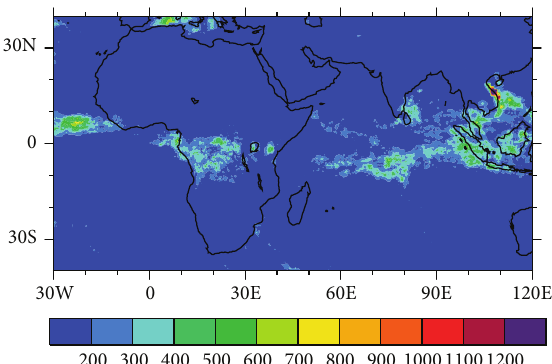
Figure 5: Rainfall (in mm) during November from the TRMM